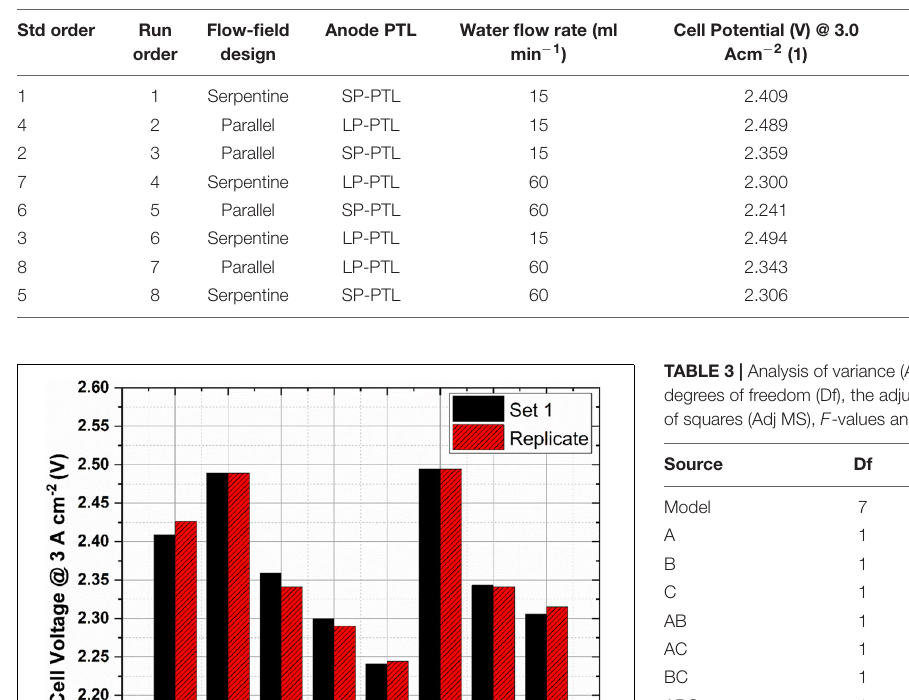
TABLE 2 | Experimental design layout and results.